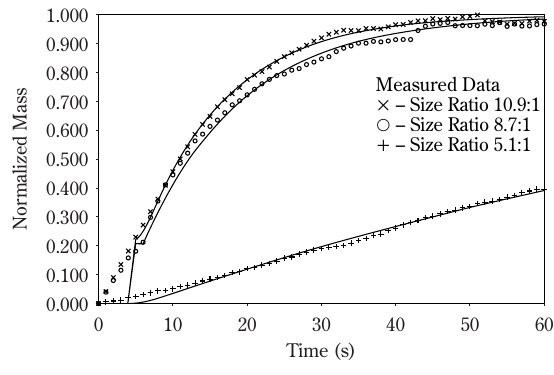
Fig. 5 Measured ( (cid:1) , (cid:1) , (cid:6) ) and convective-diffusive segregation constitutive model calculated ( (cid:4) ) normalized mass ver- sus time data (cid:4) Strain (cid:5) 15%, Cycle Speed (cid:5) 0.75 Hz, Bed Depth (cid:5) 7.62 cm